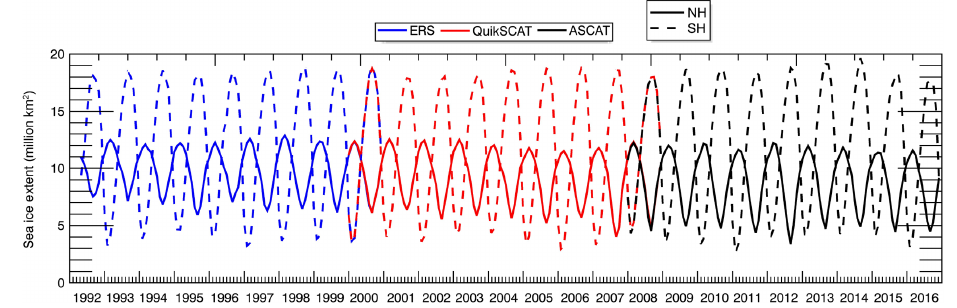
Figure 4. Time series of monthly Arctic (continuous) and Antarctic (dashed) scatterometer sea ice extents from 1992 to 2016.